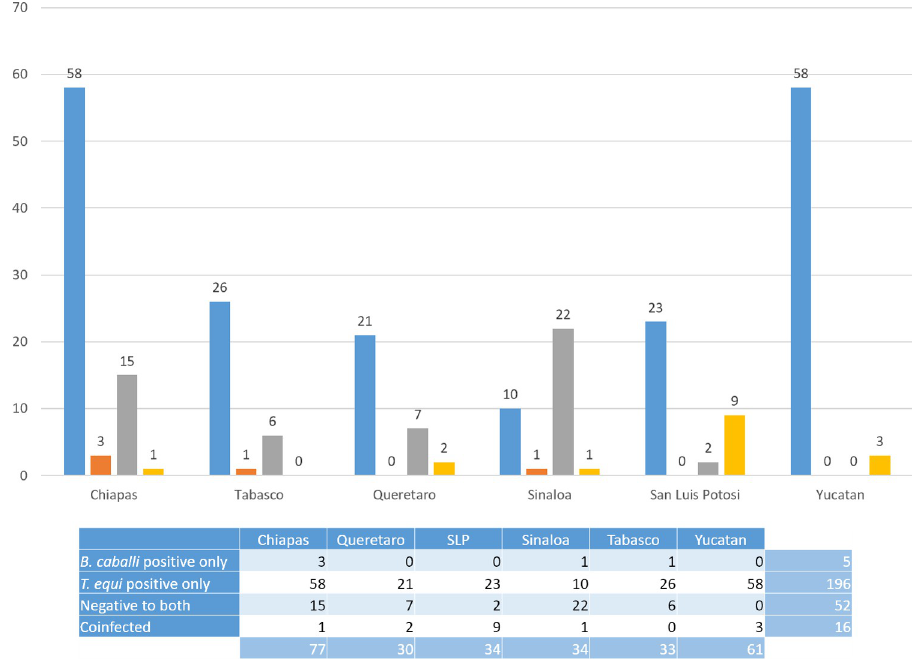
Fig 5. Molecular detection by nPCR. Positive samples to T . equi (blue bars). Positive samples to B . caballi (orange bars). Negative samples (grey bars). Coinfected samples (yellow bars). The table section shows a summary of the